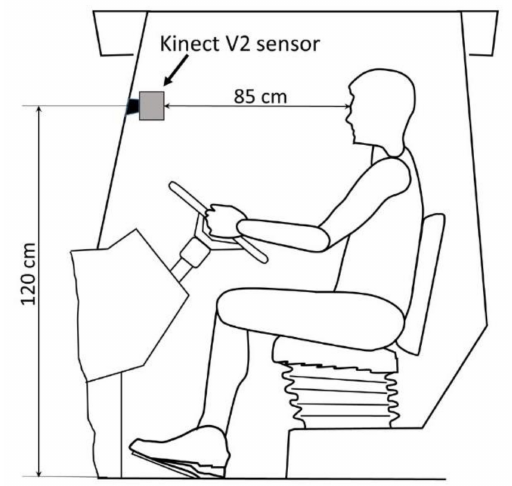
Figure 7. Scheme of the tractor cabin with the Kinect sensor